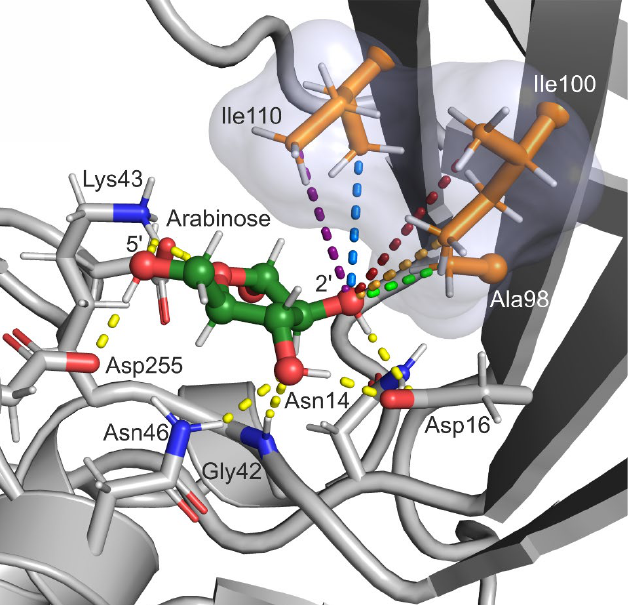
Figure 5. The position of arabinose in the active site of Eco RK (structure obtained through cluster analysis of 400-ns long MD trajectory). The semi-transparent surface represents the hydrophobic interface in the lid domain, formed by Ala98, Ile100 and Ile110.Residues 248–251 and 285–295 are hidden. Carbon atoms of arabinose are colored green, carbon atoms of residues Ala98, Ile100 and Ile110 – orange, oxygen atoms – red, nitrogen atoms – blue. Yellow dashed lines represent polar contacts; other colors distances measured throughout the MD simulation and represented in Figure 4F,G. Visualization was performed in PyMOL 2.0 (Schrödinger, LLC).